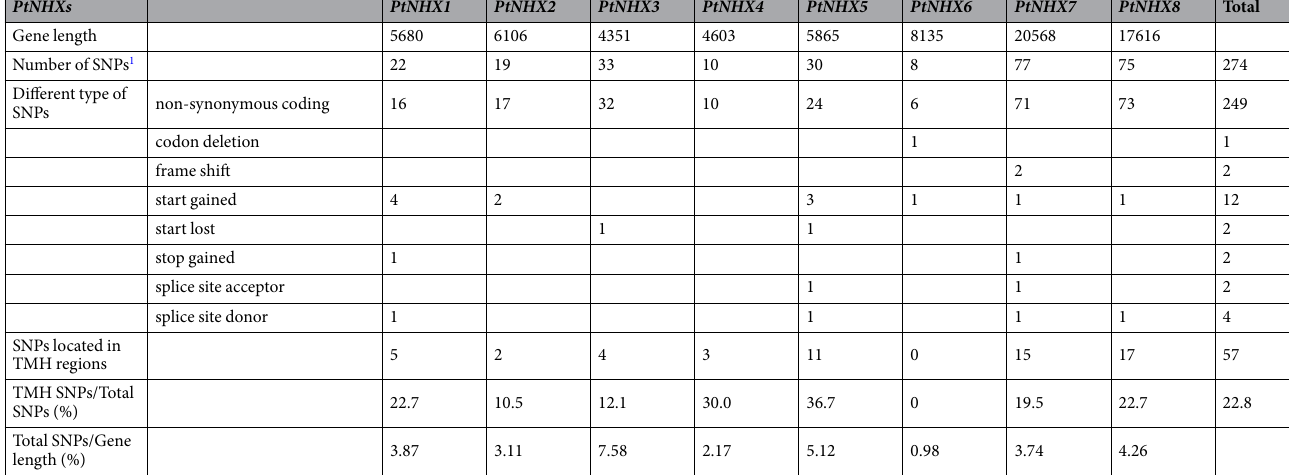
Table 5. Summary of SNPs in PtNHX genes. 1 Only the SNPs affect the composition of the proteins were listed in here, i.e. synonymous SNPs were not analyzed in this